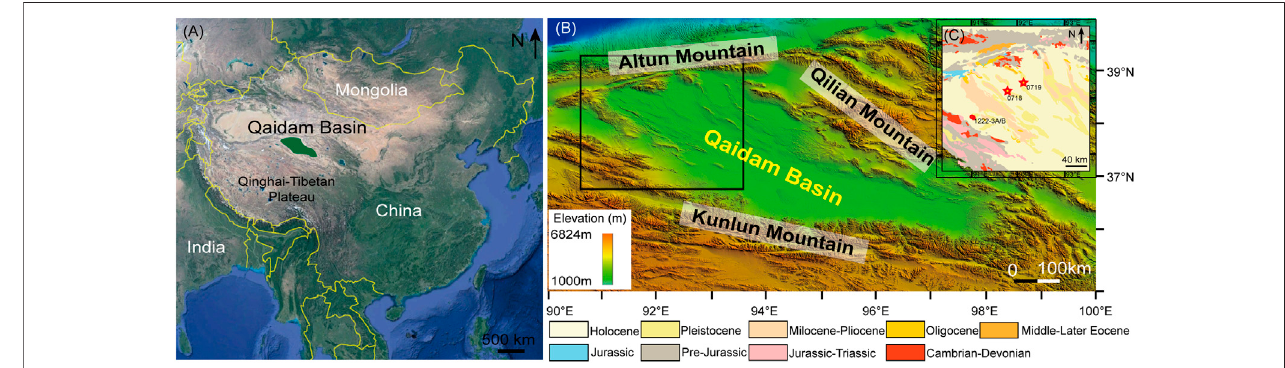
FIGURE 1 | The location of the Qaidam Basin and the geological map of the study area. (A) The location (green area) of the Qaidam Basin on the Tibetan Plateau. (B) DigitalelevationmodelmapoftheQaidamBasin,withtheblackopensquaremarkingourstudyarea. (C) Thegeologicalmapofthestudyareaandthesamplingsites (Cheng et al.,